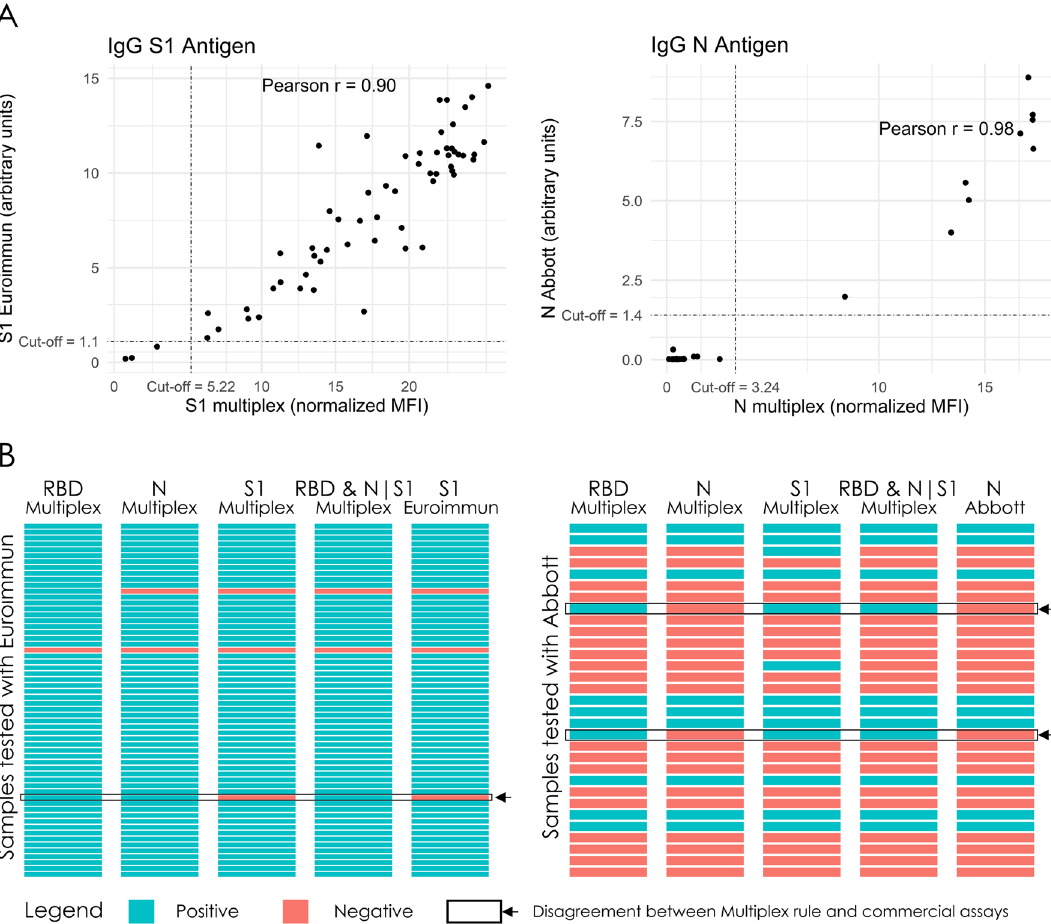
Figure 2. Validation of the multiplex assay against commercial serological assays. ( A ) Scatter plot of the S1 and N single-antigen readouts of the multiplex IgG assay (S1 multiplex and N multiplex) against results from the Euroimmun S1 (n = 60) and Abbott N (n = 31) commercial assays, respectively. The y axis corresponds to commercial assay measurements (arbitrary units), while the x axis to normalized MFI of the multiplex assays. Dotted lines correspond to assay cut-offs for positivity. A Mean + 5 SD cut-off was used for the developed multiplex assays, while the manufacturer’s recommended cut-off was used for the commercial assays. ( B ) Heatmap of diagnostic outcomes depicting the agreement between the multiplex and the commercial assays. The same cut-off values as ( A ) were used for